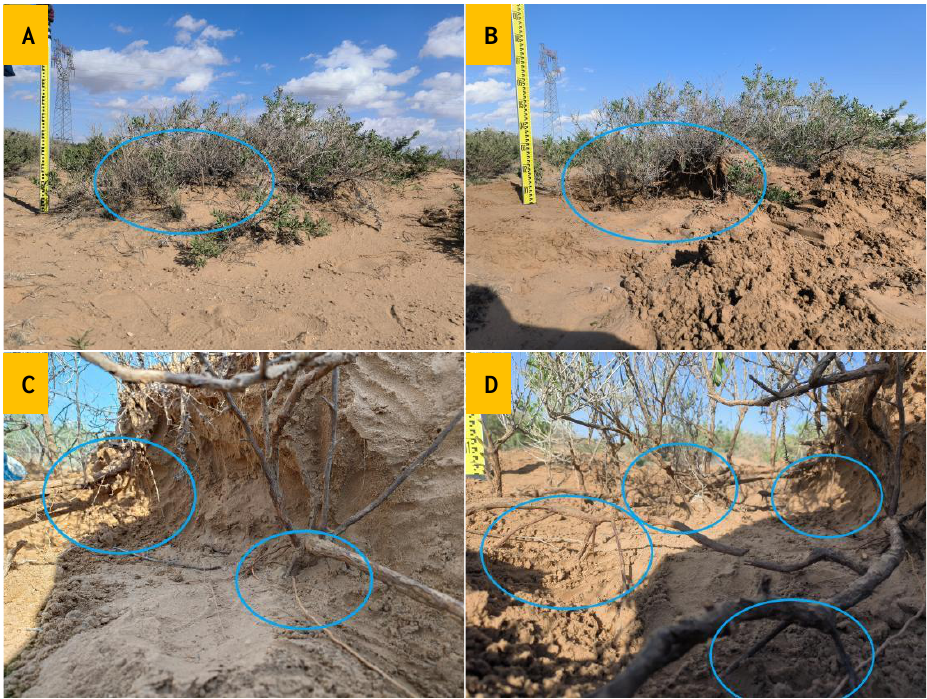
Figure 6. Adventitious roots inside the nabkha. ( A ) Before excavation of the nabkha; ( B ) after excavation of the nabkha; ( C , D ) close-up photo of adventitious roots.